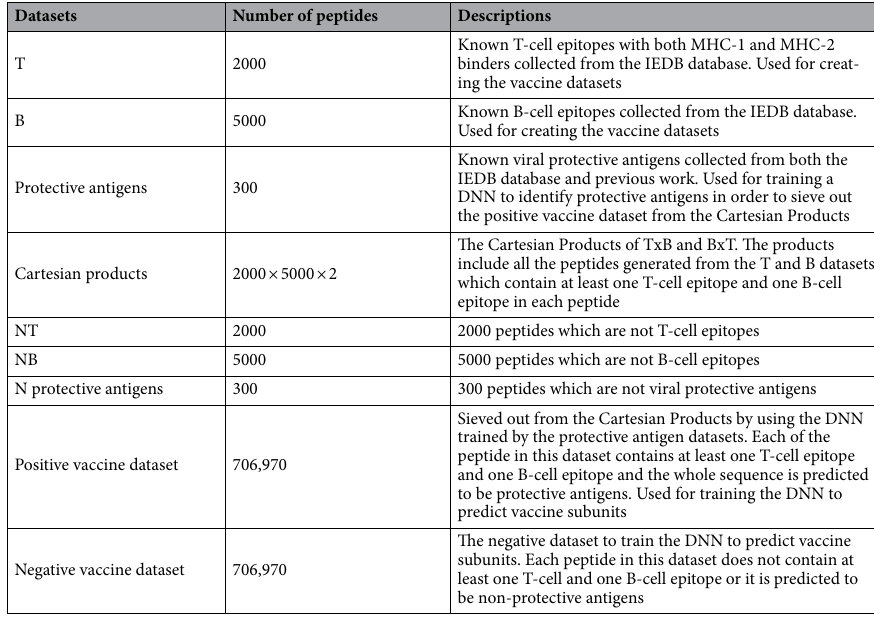
Table 1. Description of the datasets used for analysis and DNN training.